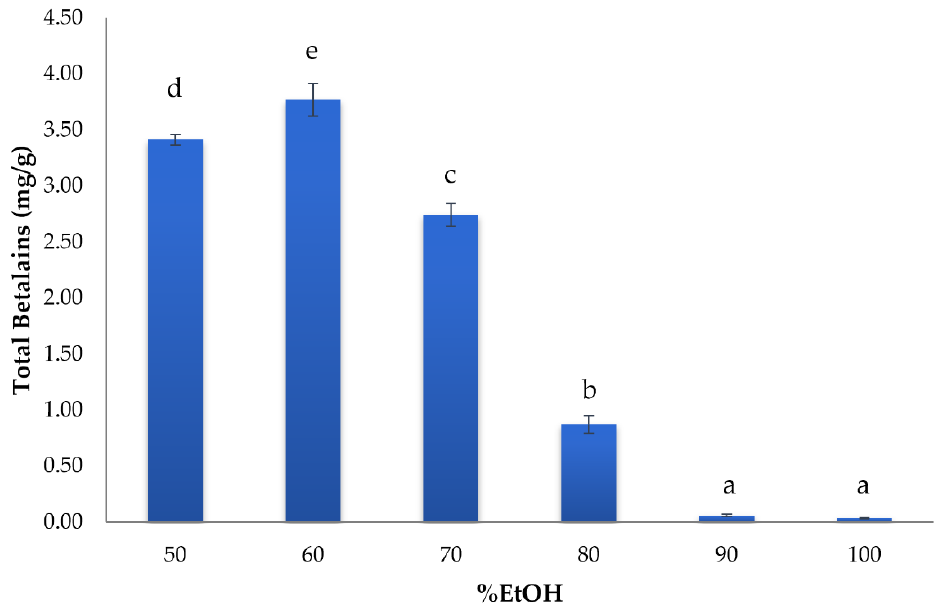
Figure 3. Total betalains extracted (mg/g sample) according to the percentage of EtOH in the solvent. Different letters indicate significant differences with 95% of confidence according to Duncan’s post hoc analysis.